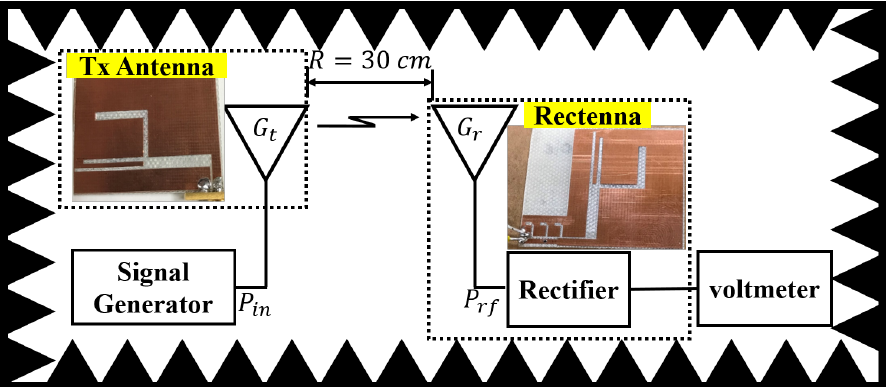
Figure 7. Rectenna measurement setup and the prototype of both the rectenna and antenna are embedded in the